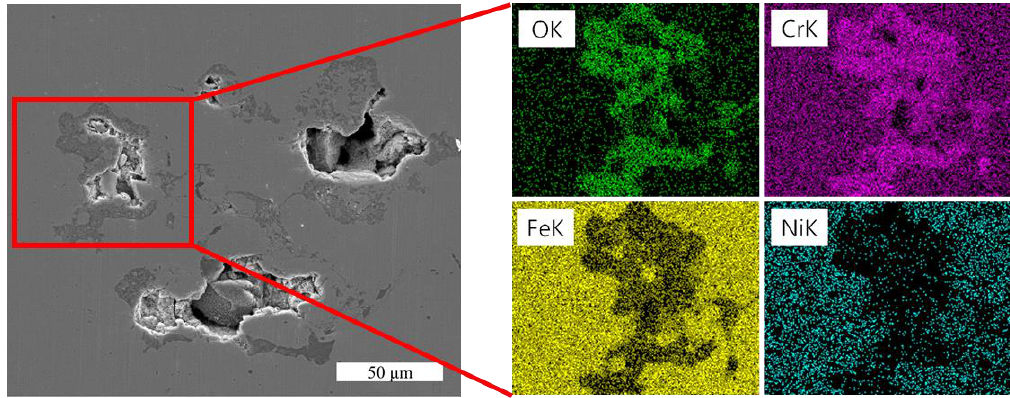
Figure 17. The result of EDS mapping for the interface pores of sample 2.